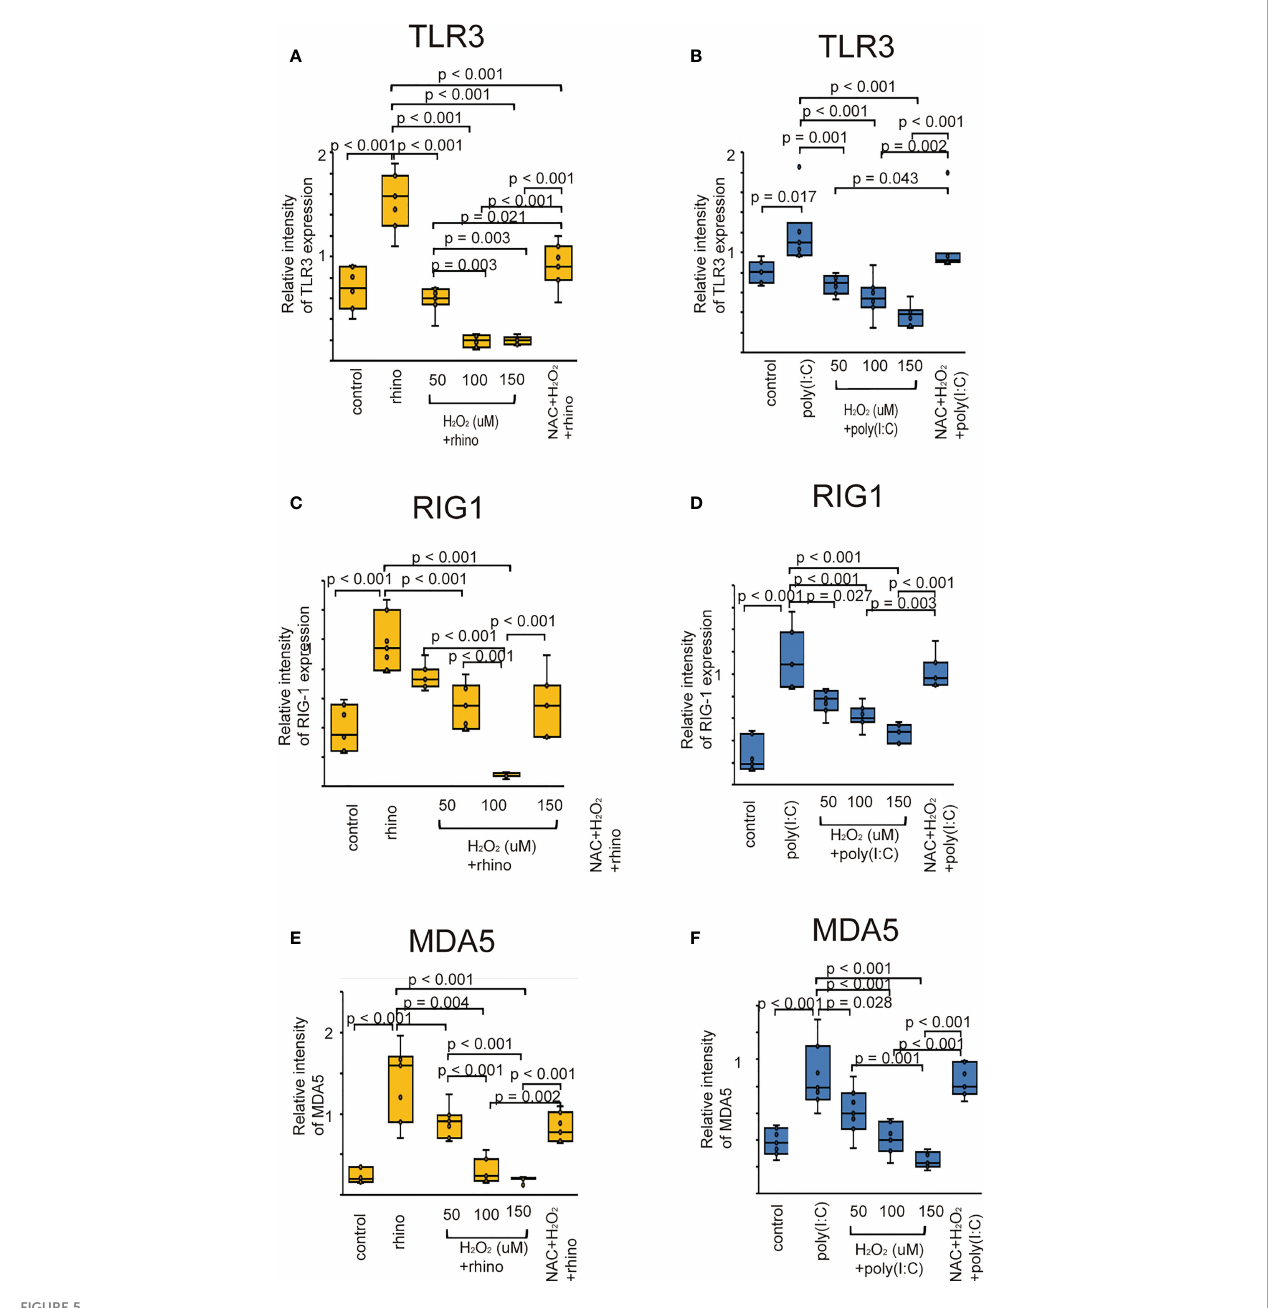
dependent manner (Figure 5). Their downregulatory effect induced by H 2 O 2 pretreatment was inhibited in cells pretreated with NAC (Figure 5). These fi ndings were veri fi ed by the data of RT-qPCR (Supplementary Figure 9).